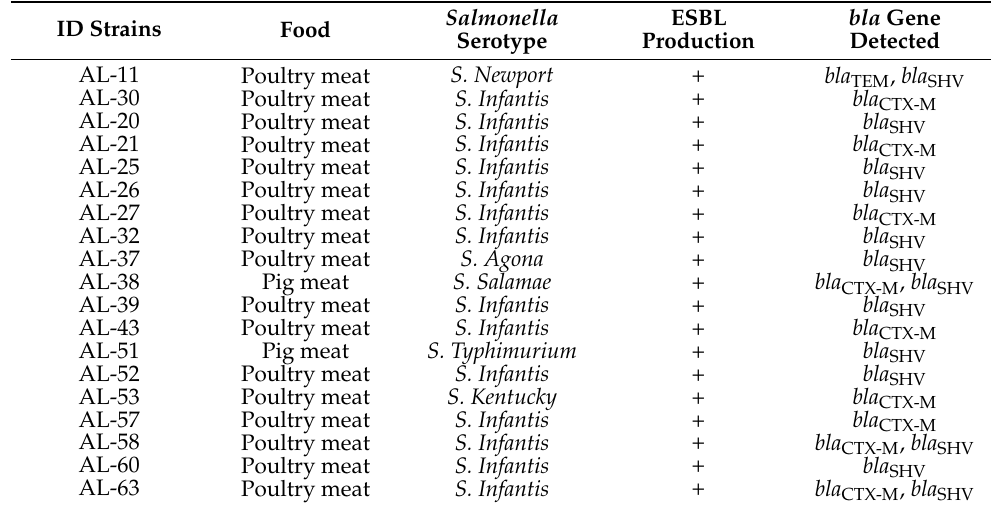
Table 3. Beta-lactamase resistance gene detection